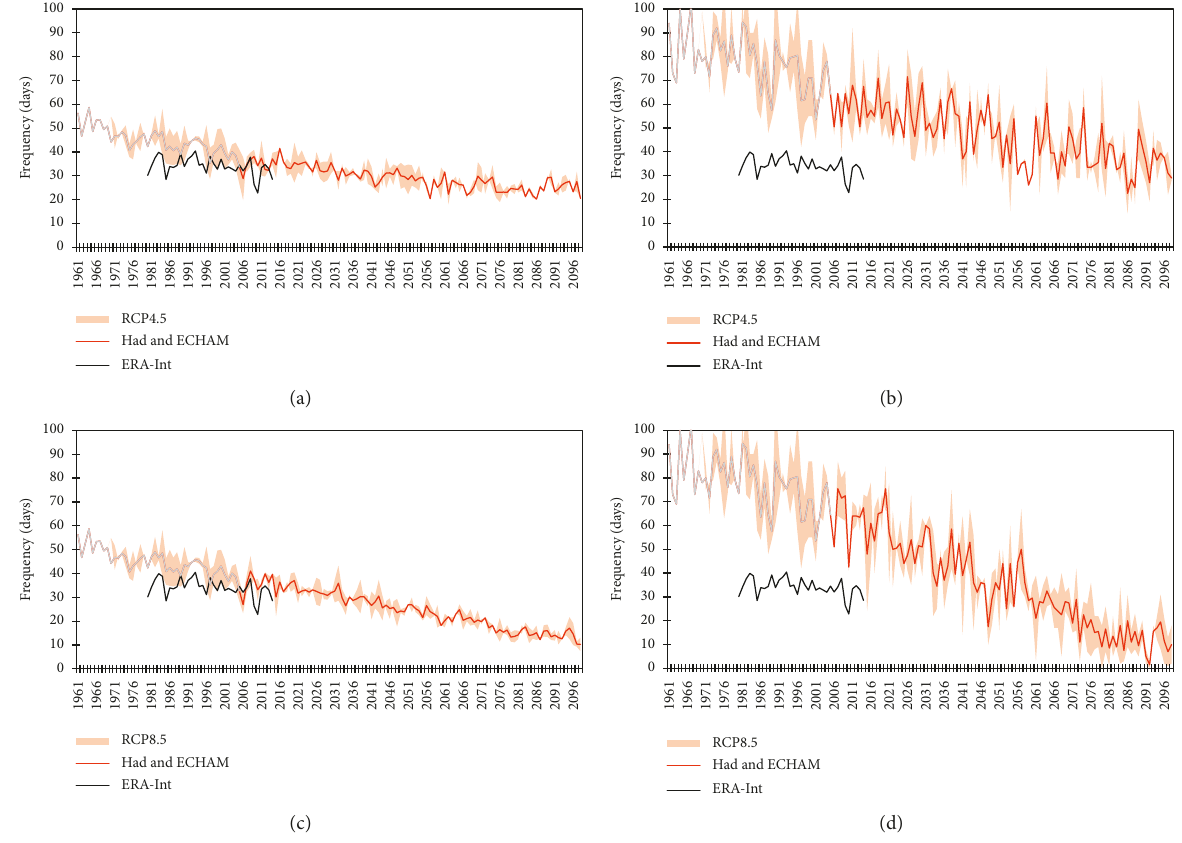
Figure 9: Number of RegCM-simulated cold nights ( T ° C) for (a) CORDEX domain with RCP4.5, (b) Arabian Peninsula subdomain min ≤ 5 with RCP4.5, (c) CORDEX domain with RCP8.5, and (d) Arabian Peninsula subdomain with RCP8.5. Average is taken from HadGEM2- and ECHAM6-driven runs. Shaded area shows the range, and gray color indicates the past